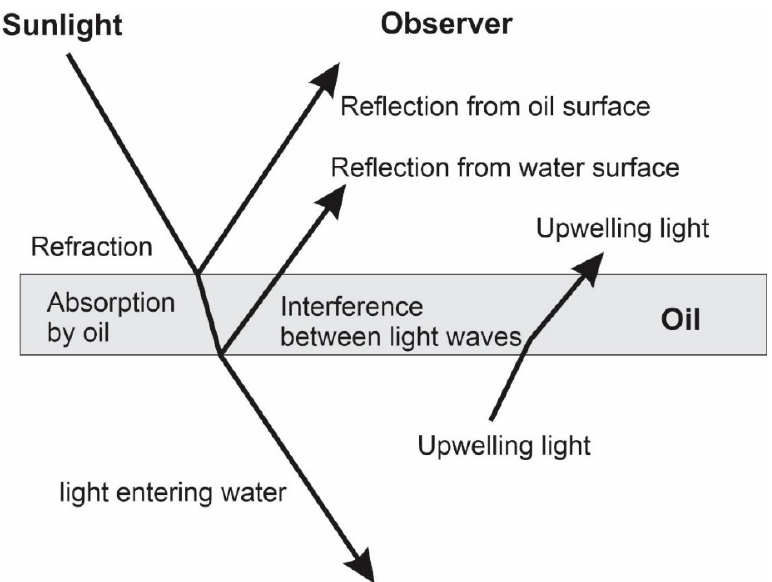
Figure 1. Fundamental optical phenomena involved in the oil coloration of thin slicks. This diagram is applicable only to the consideration of the appearance of thin slicks.